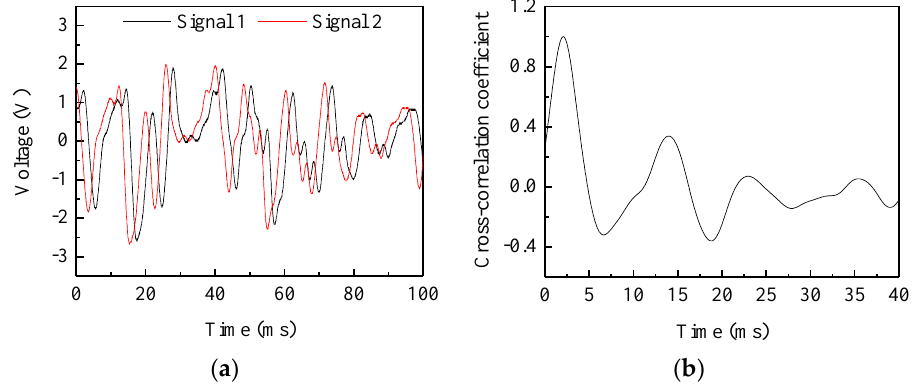
Figure 7. Typical electrostatic signals and their correlation function: ( a ) Electrostatic signals; ( b ) Correlation function.